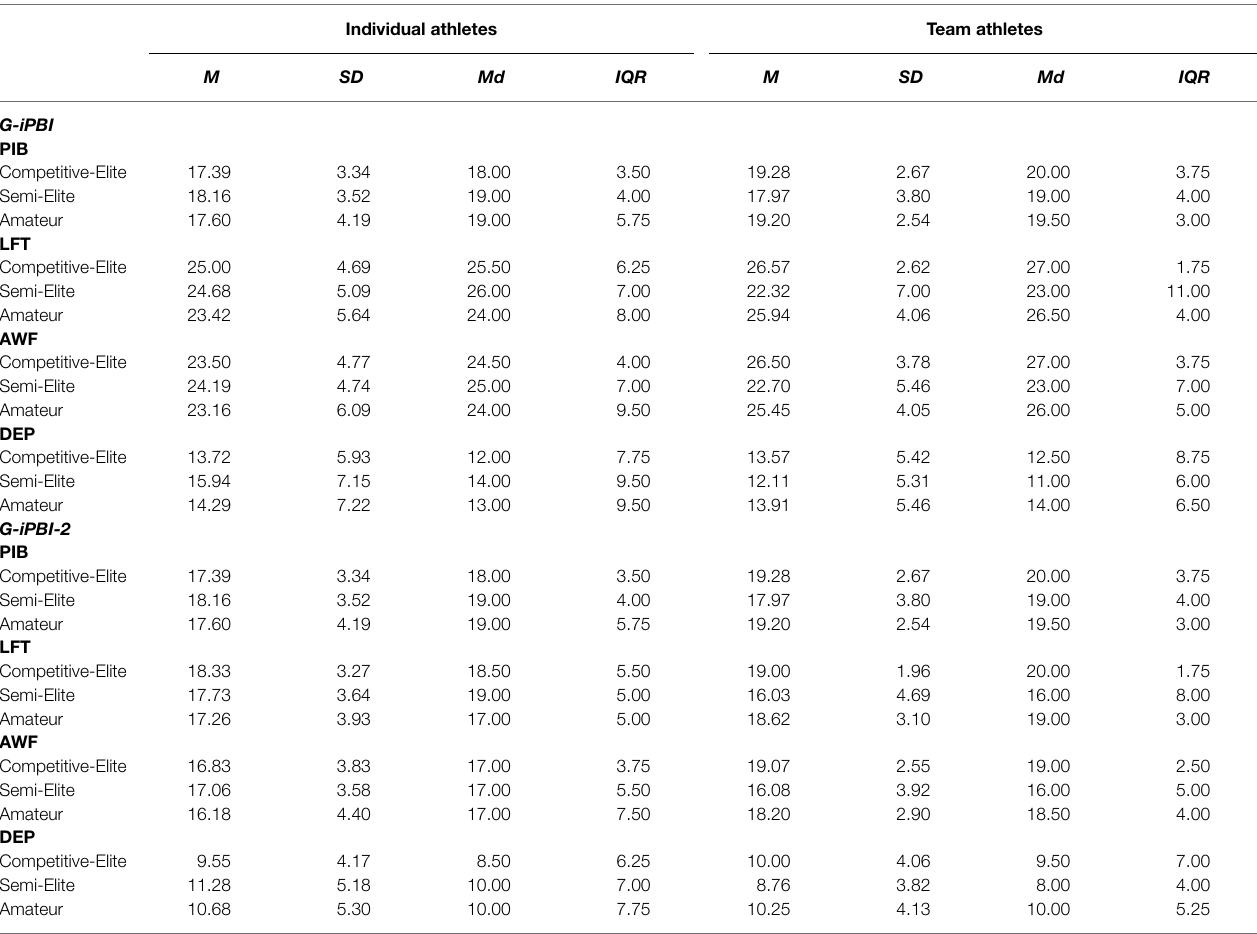
TABLE 5 | Mean values (M), standard deviations (SD), median values (Md), and interquartile ranges (IQR) separated by performance level and sport-type of the